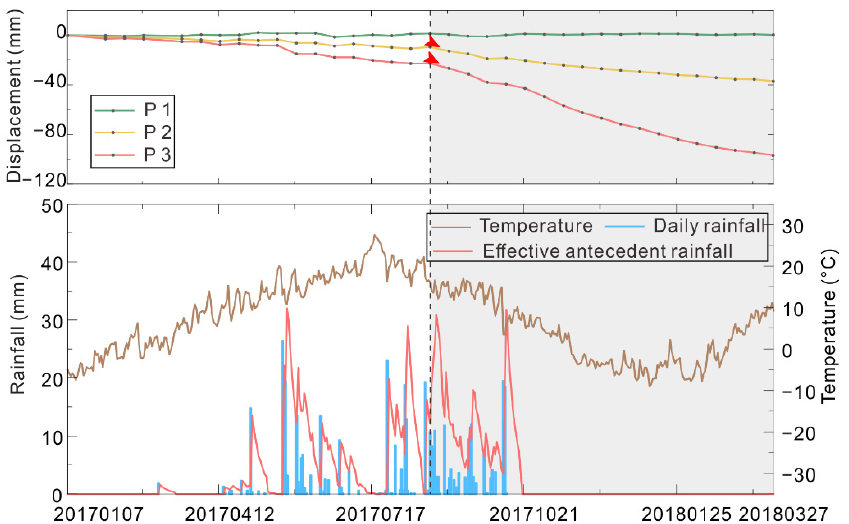
Figure 10. The time-series LOS displacement, effective antecedent rainfall and temperature before the landslide occurred. The locations of P1, P2 and P3 are shown in Figure 6. The red triangle represents the beginning of the accelerated change. The gray bar represents the time span of the accelerated displacement.